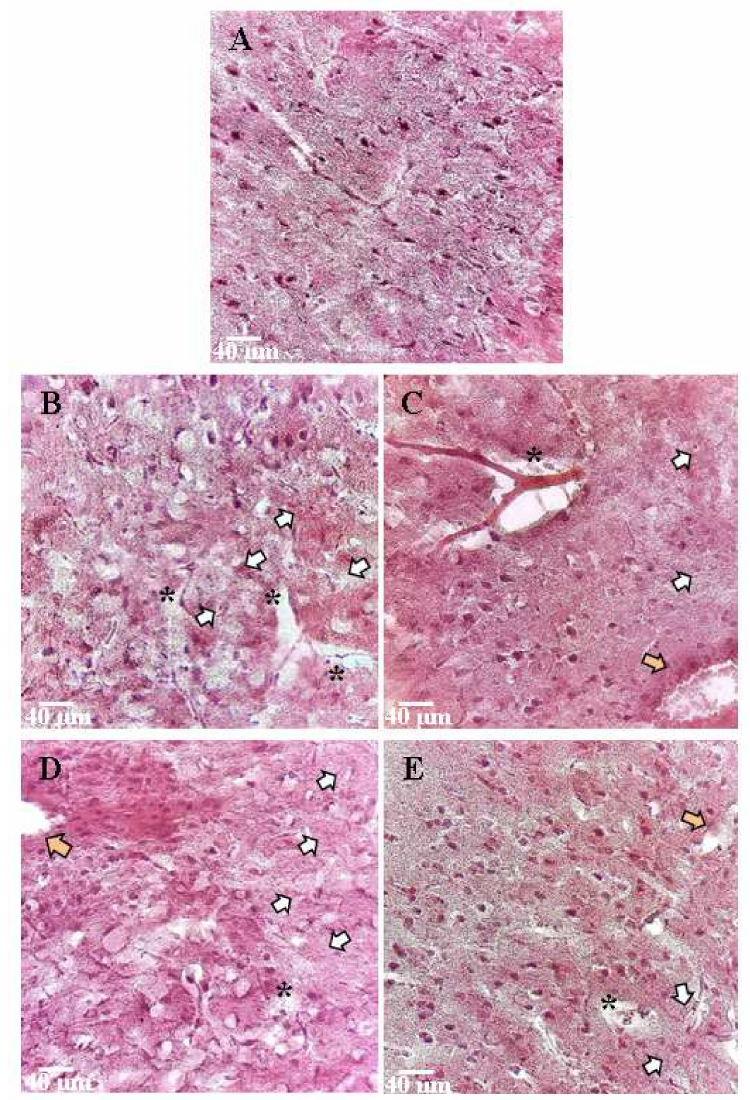
Figure 6. Representative microphotographs of histological specimens of the cerebral cortex of mice in the modeling of acute hypobaric hypoxia and ischemia. Hematoxylin-eosin staining, magnification × 40. ( A )—Intact, ( B )—Hypoxia, ( C )—Hypoxia + RIPK inhibitor Necrostatin-1, ( D )—Ischemia, and ( E )—Ischemia + RIPK inhibitor Necrostatin-1. * —indicate the expansion and edema of the pericapillary space. White arrows indicate edema of the nerve tissue and nerve cells with indistinct edges or unformed nerve cells. Orange arrows indicate areas of hemorrhage and inflammation with pronounced cellular infiltration. Scale bar 40 µ